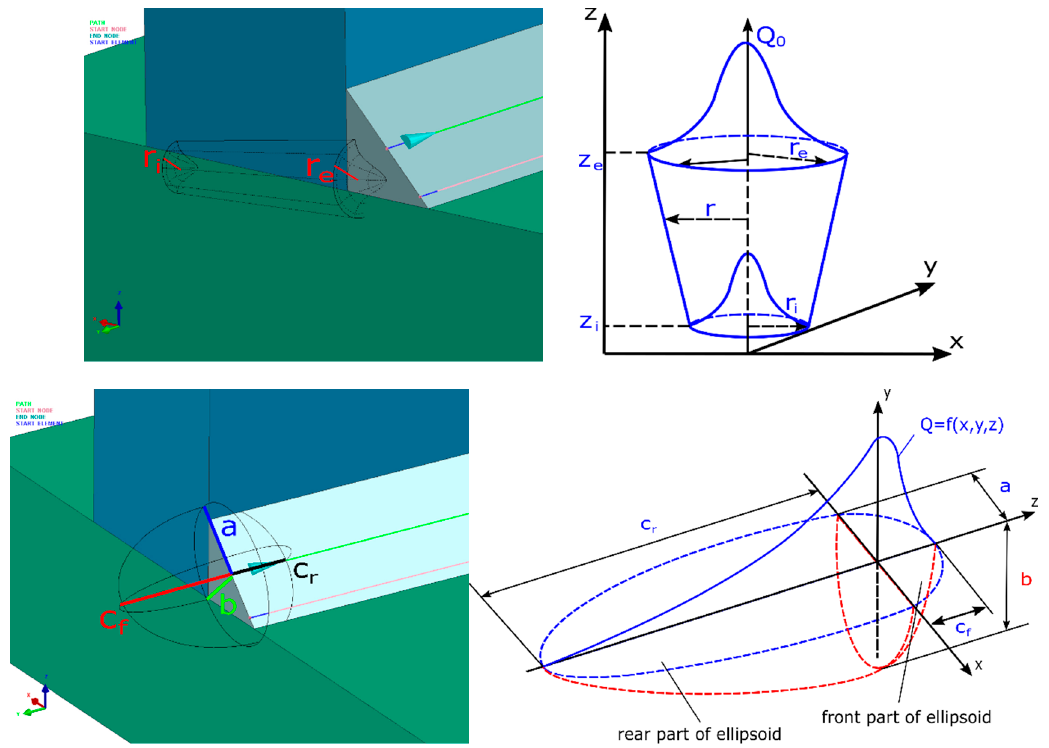
Figure 3. View of used heat source models—3D conical and double-ellipsoidal (Goldak’s) model.